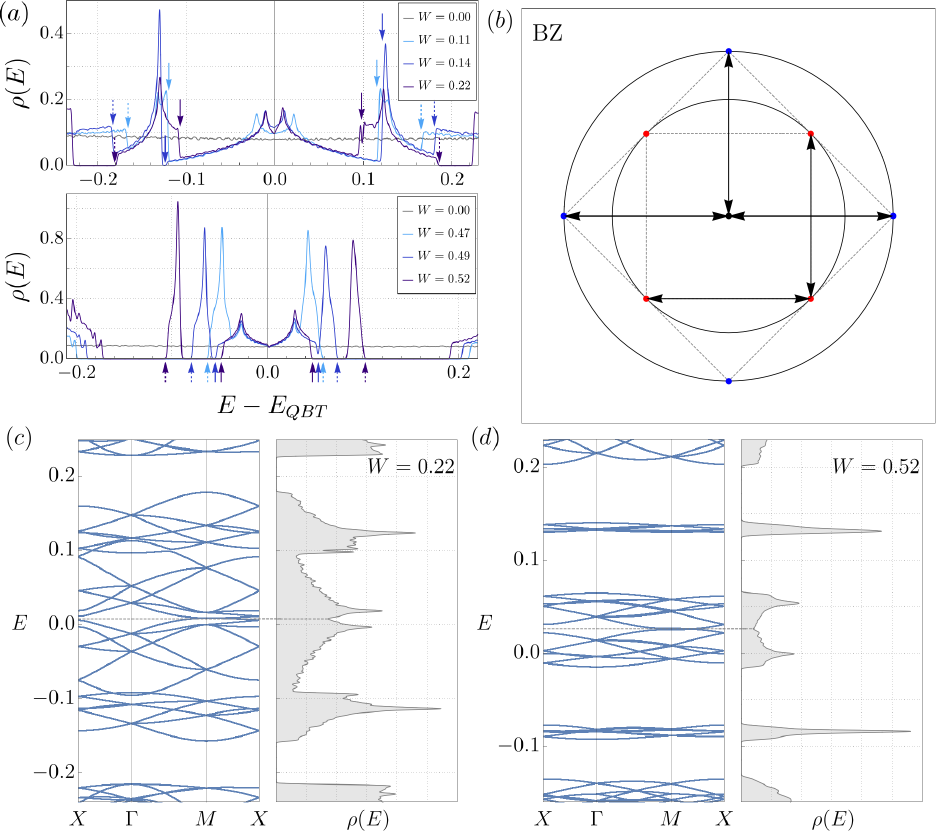
Figure 5: Miniband formation and renormalized dispersion : (a) DOS for different / 2 π = F / L , L = F = 144. The boundary of the first (solid) W values with Q L n − 4 12 and second (dashed) minibands are shown in arrows. (b) The schematic figure of the Fermi surface and points connected via the quasiperiodic potential through second (red dots) and fourth (blue dots) order processes. The arrows are of length Q . (c,d) The DOS for W = 0.22,0.52 are plotted side-by-side with the corresponding band structure, calculated for a L = 21